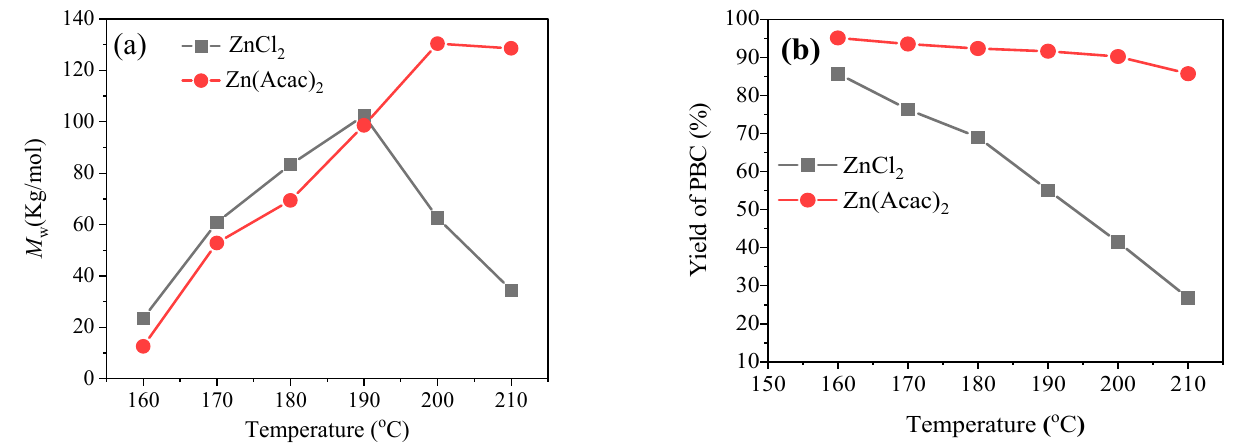
Figure 3. The effect of reaction temperature on the ( a ) M w and ( b ) yield of PBC polymer over Zn(Acac) 2 and ZnCl 2 . Reaction conditions: molar ratio of Zn 2+ to DPC 0.10%, reaction time 90 min.